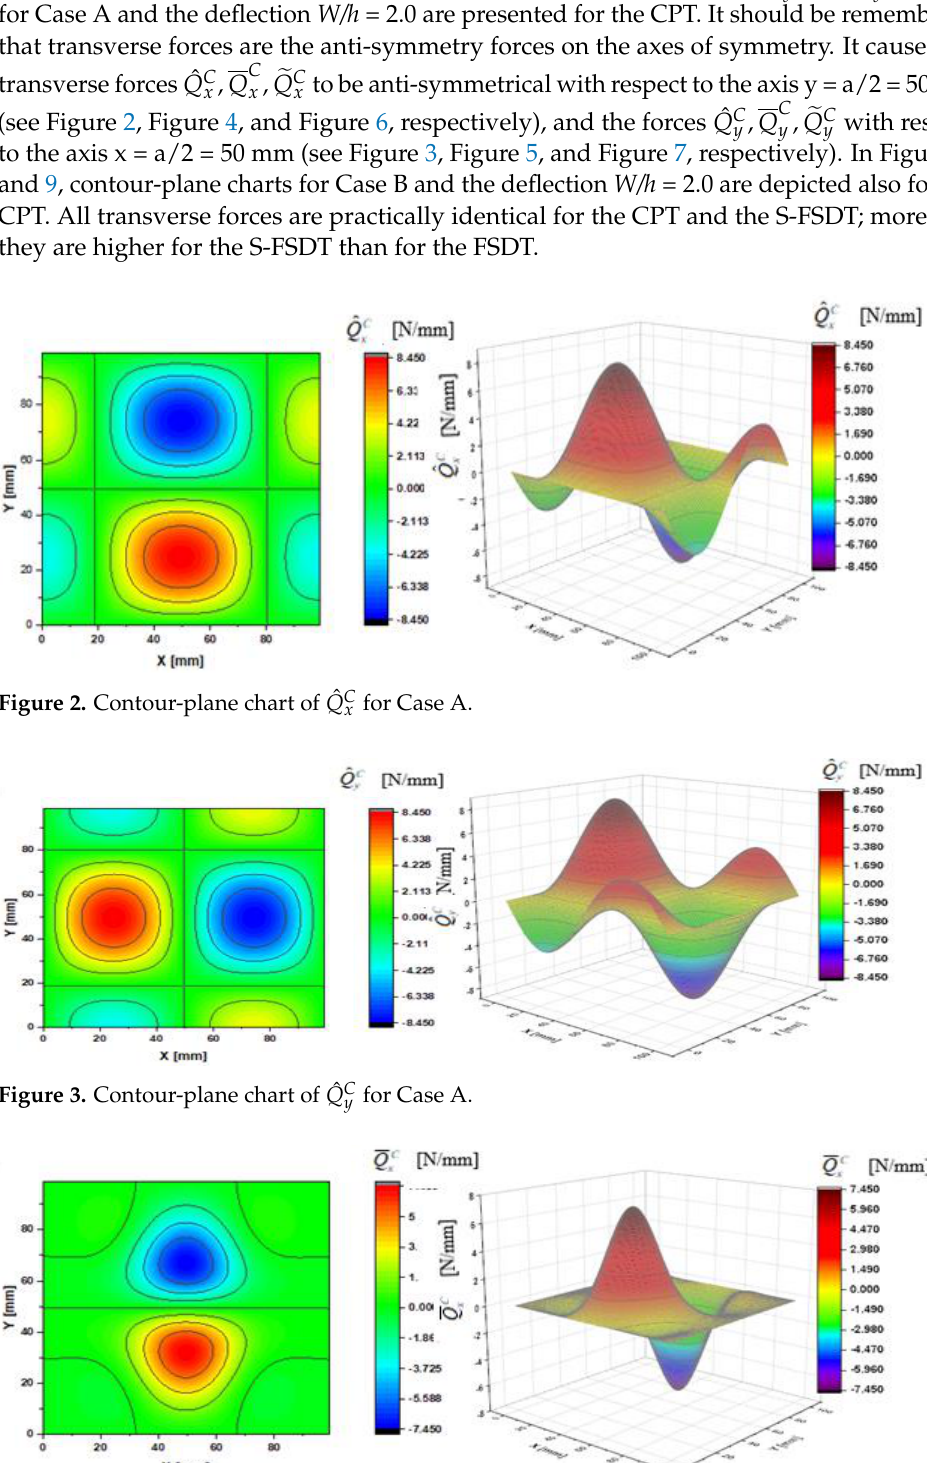
C Q for Case A. Q for Case A. Figure 4. Contour-plane chart of Q x for Case x x Q for Case A. x